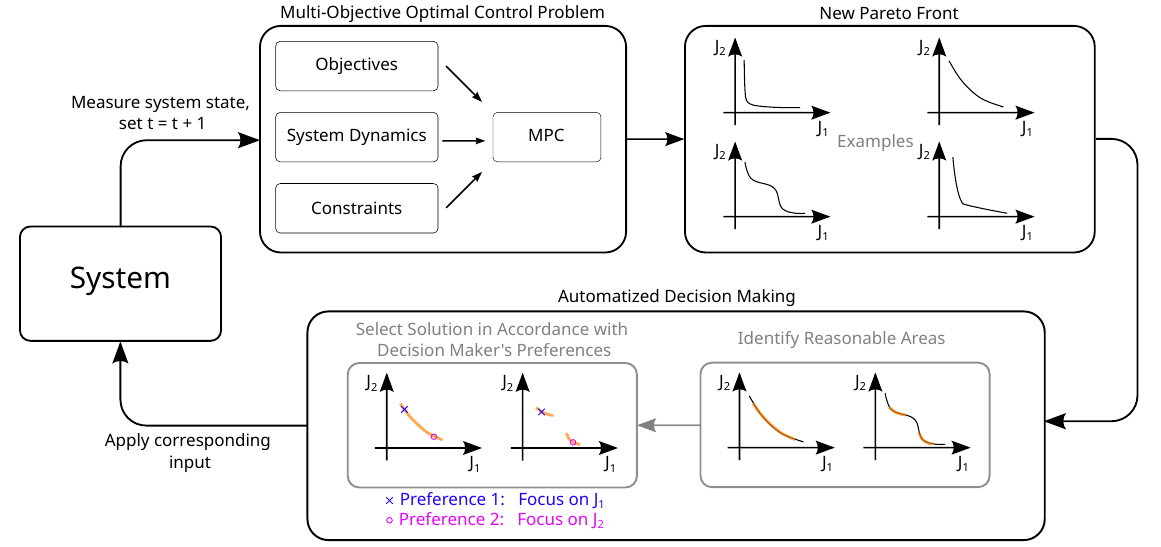
Figure 1. Illustration of the presented approach in the automatized decision making process for multi-objective MPC. As usual in MPC, at every time step, an optimization problem (i.e., an